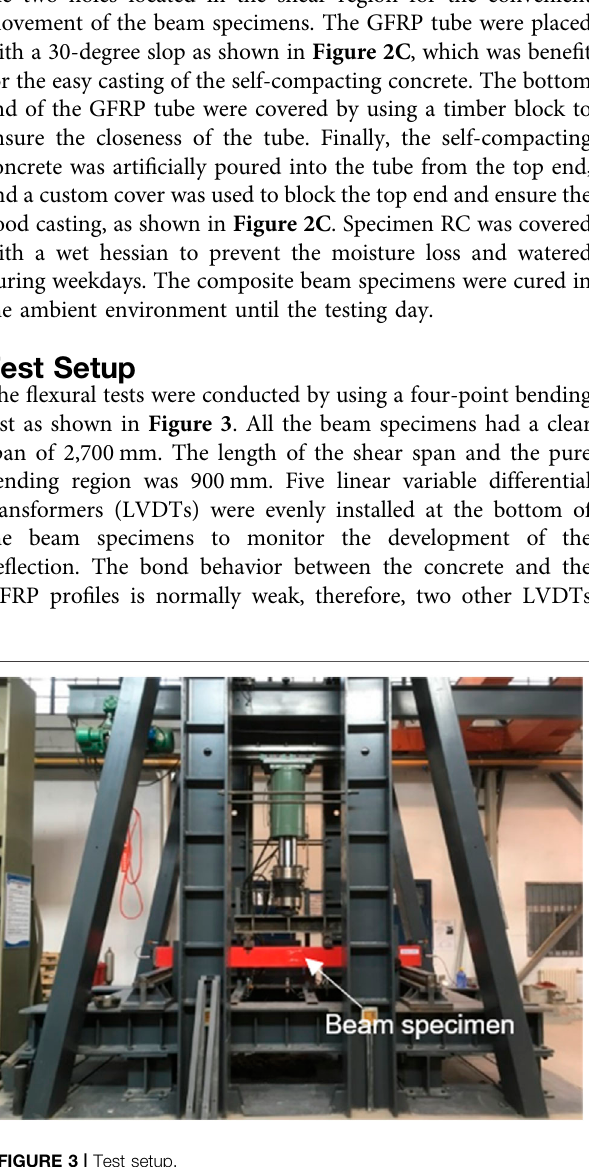
FIGURE 3 | Test setup. FIGURE 4 | Layout of strain gages